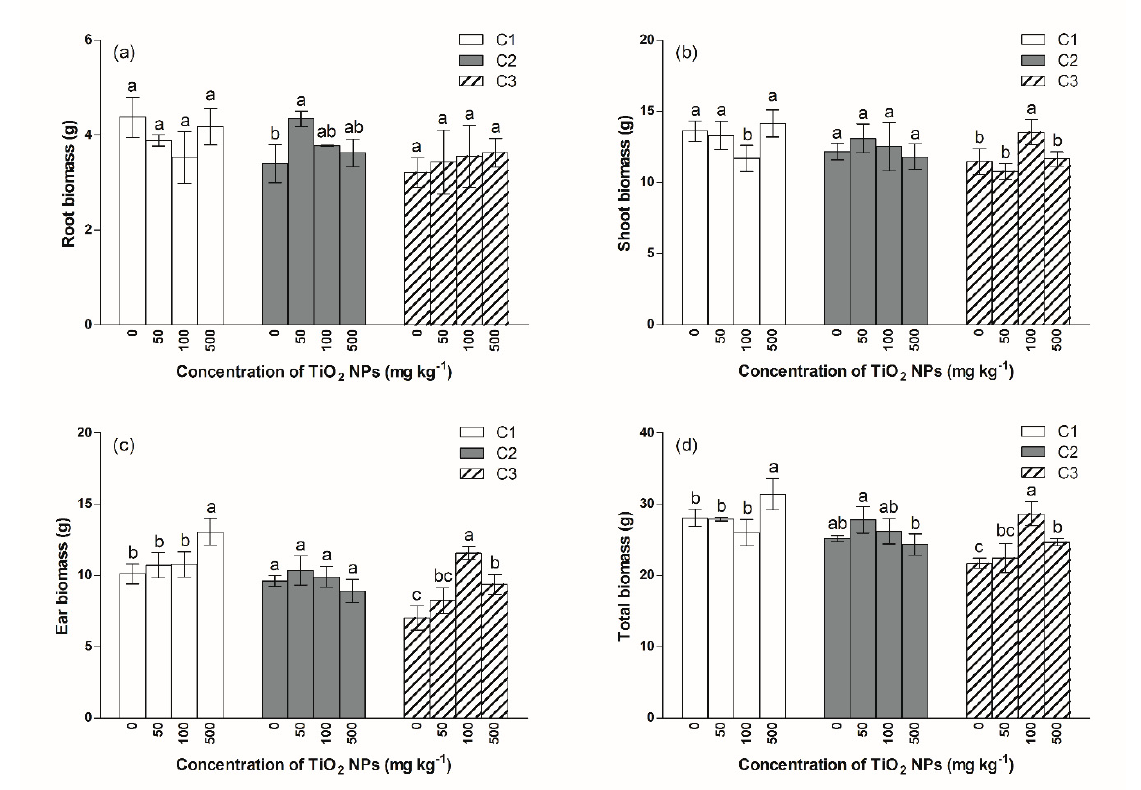
Figure 2. The impact of TiO 2 NPs on plant biomass. ( a ) root biomass, ( b ) shoot biomass, ( c ) ear biomass, ( d ) total biomass. Different letters above column indicate significant differences ( p < 0.05) between various treatment in same group.